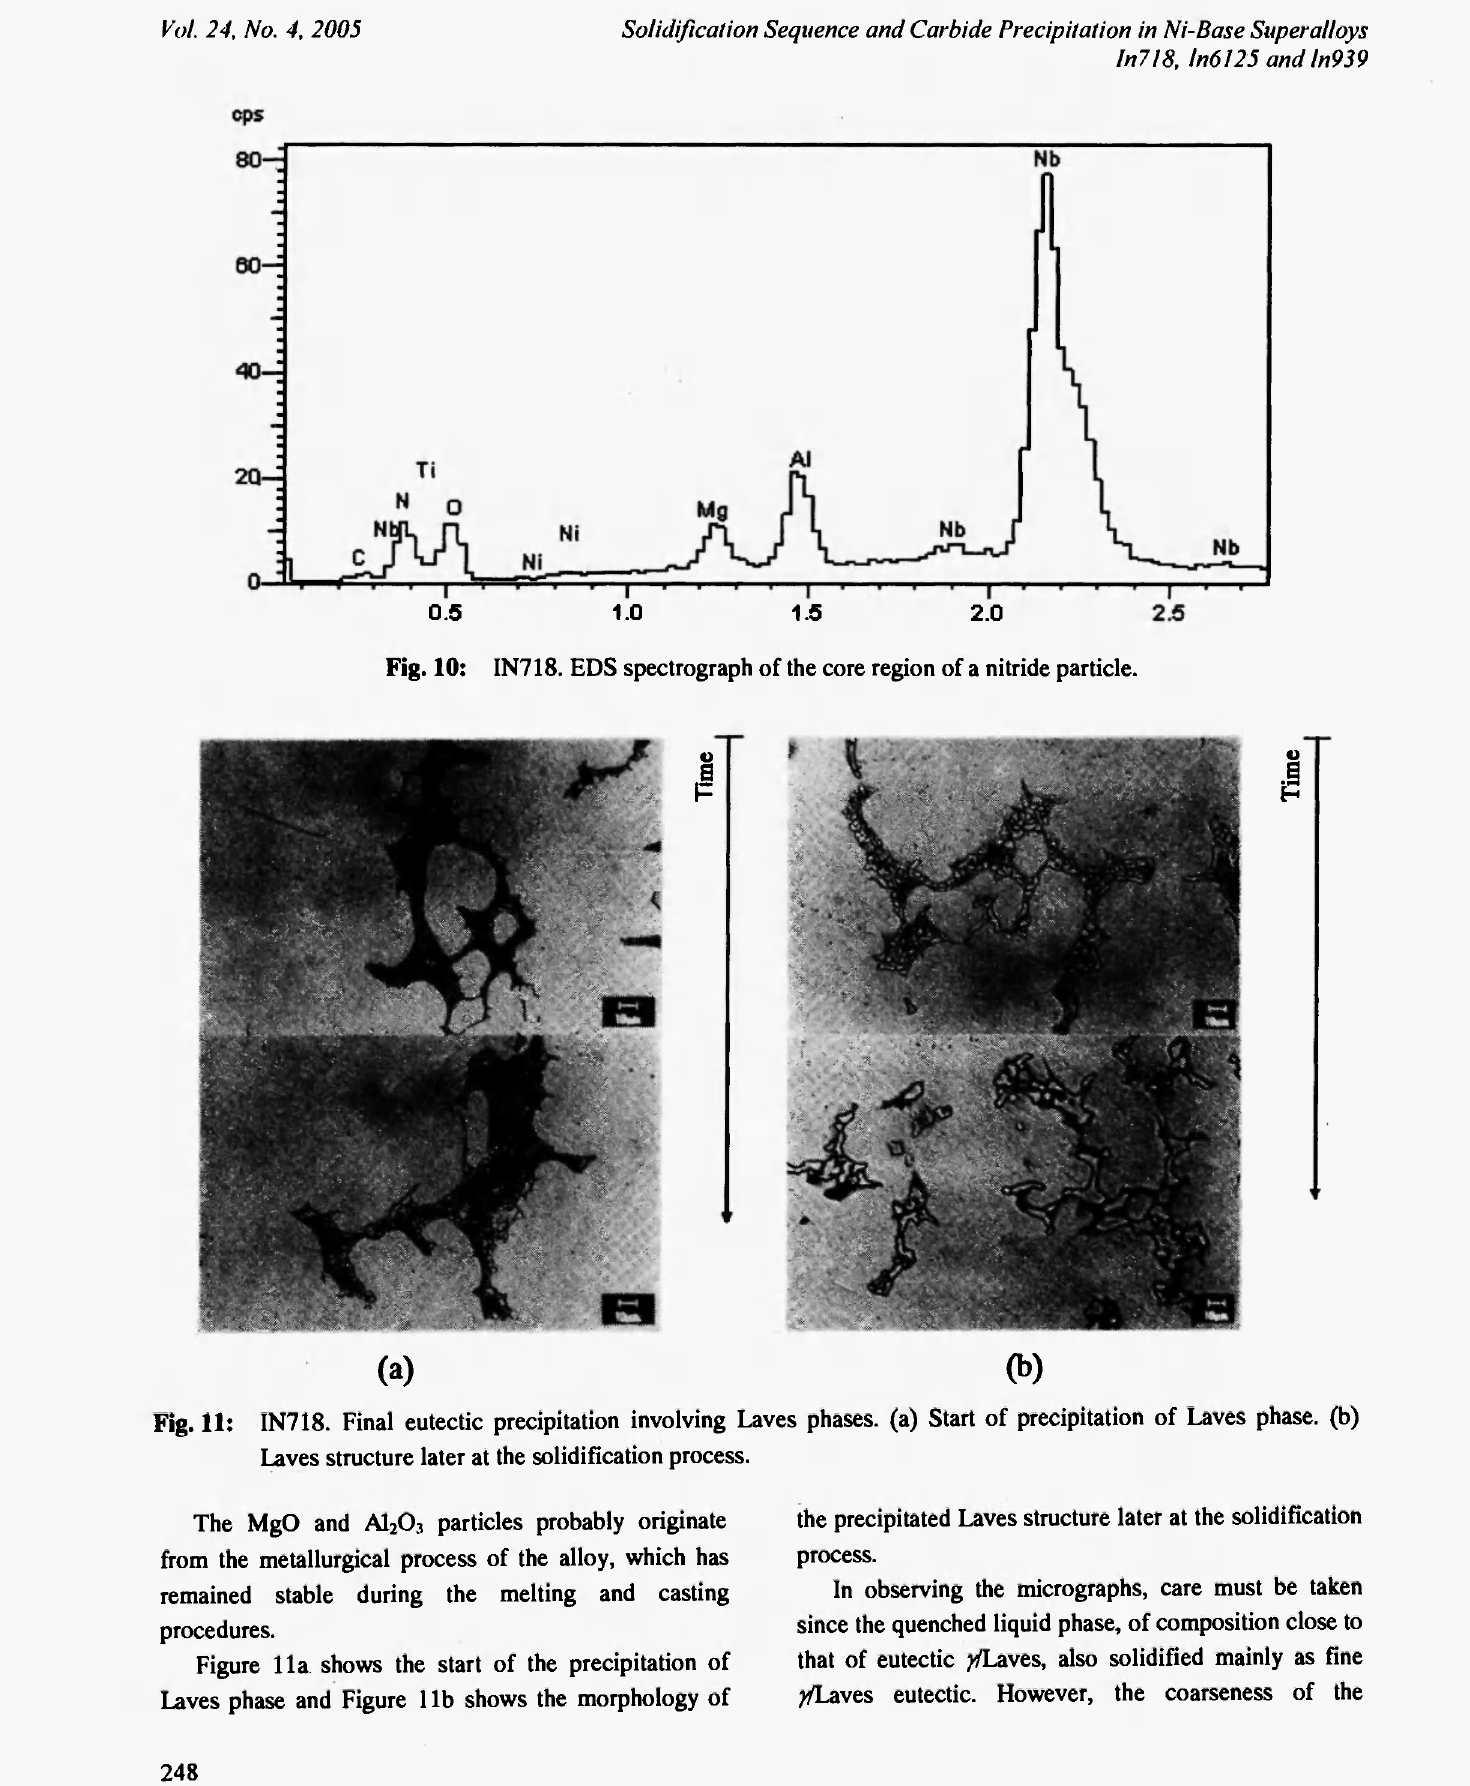
Fig. 11: IN718. Final eutectic precipitation involving Laves phases, (a) Start of precipitation of Laves phase, (b) Laves structure later at the solidification